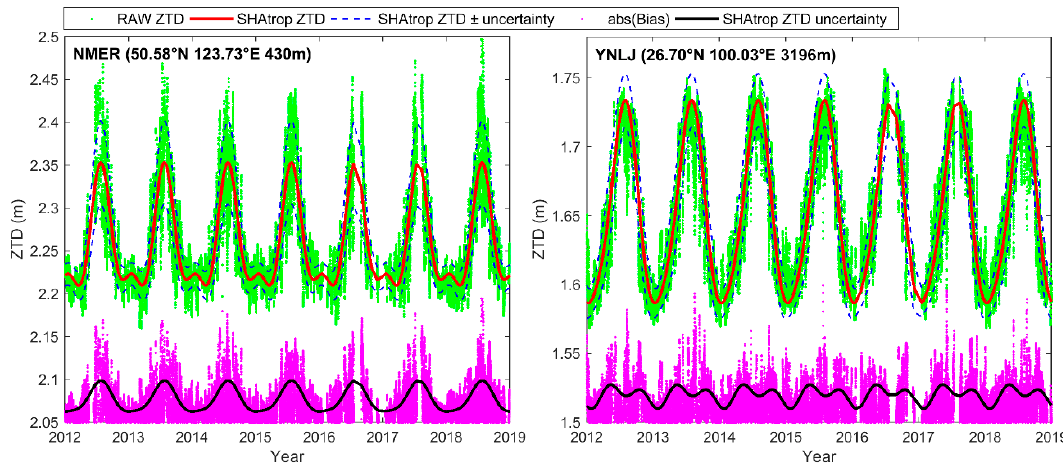
Figure 6. RAW ZTD (green) and SHAtropE ZTD (red) for two sites: NMER ( left ) and YNLJ ( right ). The absolute value (magenta) of the differences between RAW ZTD and SHAtropE, and the predicted uncertainty provided by SHAtropE (black) are presented with an offset (2.05 m at NMER and 1.50 m at YNLJ) for better visualization.